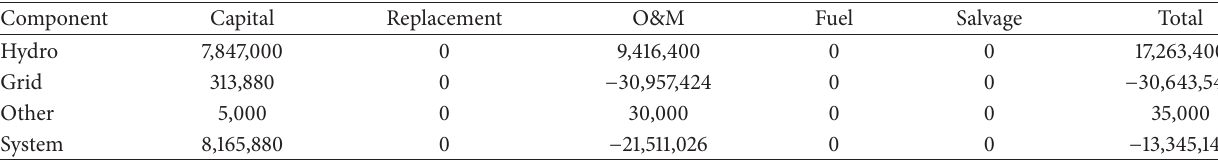
Table 7: Net present costs.